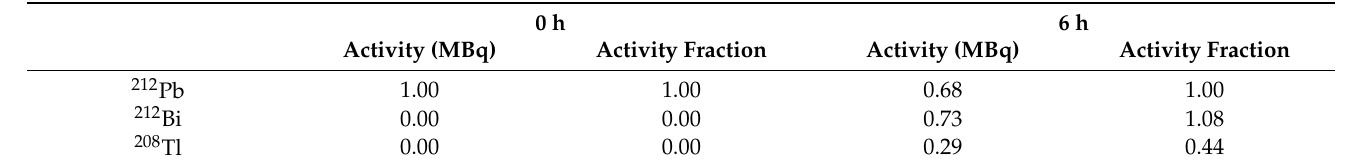
Table 3. 212 Pb, 212 Bi, and 208 Tl activity and activity fraction in injectate preparation at 0 h and 6 h for